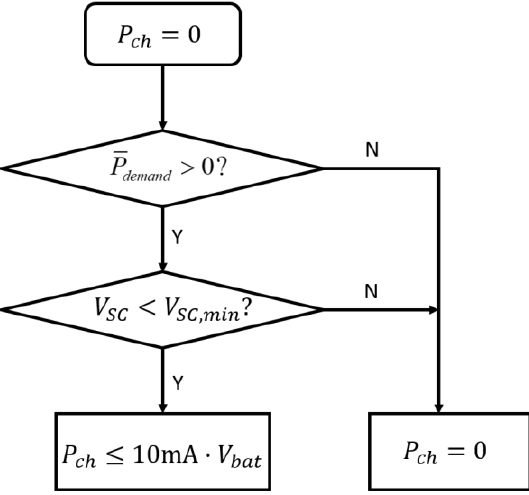
Figure 6. Modified SC first EMS of hybrid diode topology.